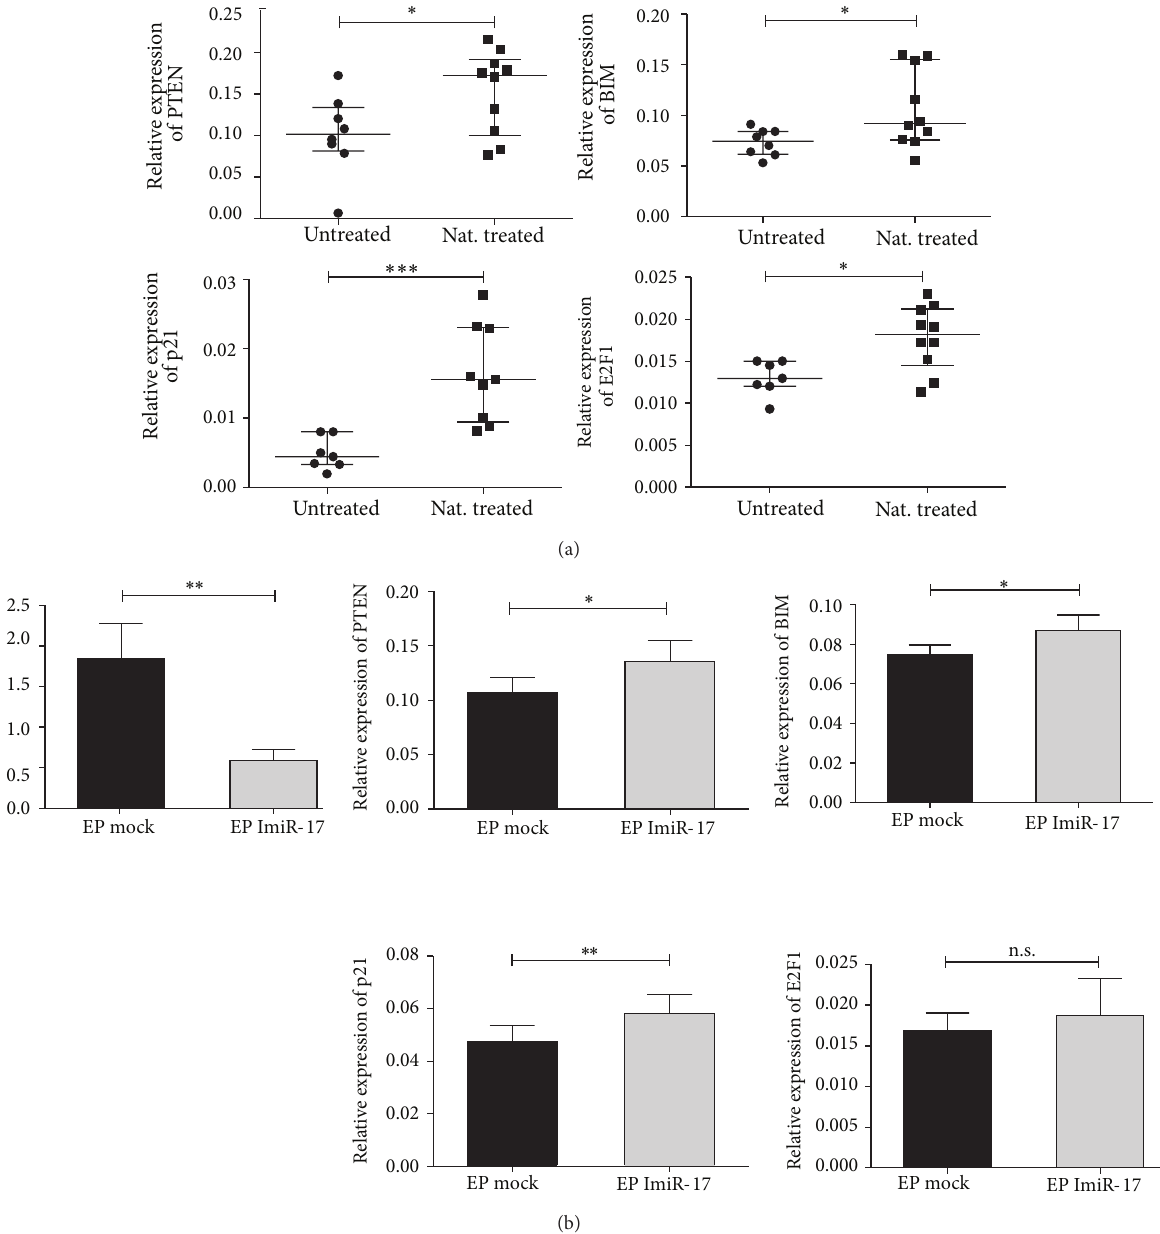
Figure 3: Expression of candidate target mRNAs. (a) Transcriptional expressions of PTEN, BIM, p21, and E2F1 were analyzed with real-time RT-PCR in CD4 + T cells from untreated and natalizumab treated patients (untreated: 𝑛 = 8 ; Nat. treated: 𝑛 = 10 ) (bars represent median with interquartile range) and (b) in freshly isolated CD4 + T cells from HVs transiently transfected by electroporation (EP) with 1 𝜇 M of miR-17 synthetic inhibitor (ImiR-17) or vehicle control (mock) ((b) middle and right panels). Analysis of miR-17 transcriptional expression ((b) left panel). Values represent mean with SEM for 8 independent experiments. Relative expression levels are depicted. Unpaired two-tailed 𝑡 -test was used. ∗∗∗ 𝑃 < 0.001 ; ∗∗ 𝑃 < 0.01 ; ∗ 𝑃 < 0.05 ; n.s.: not